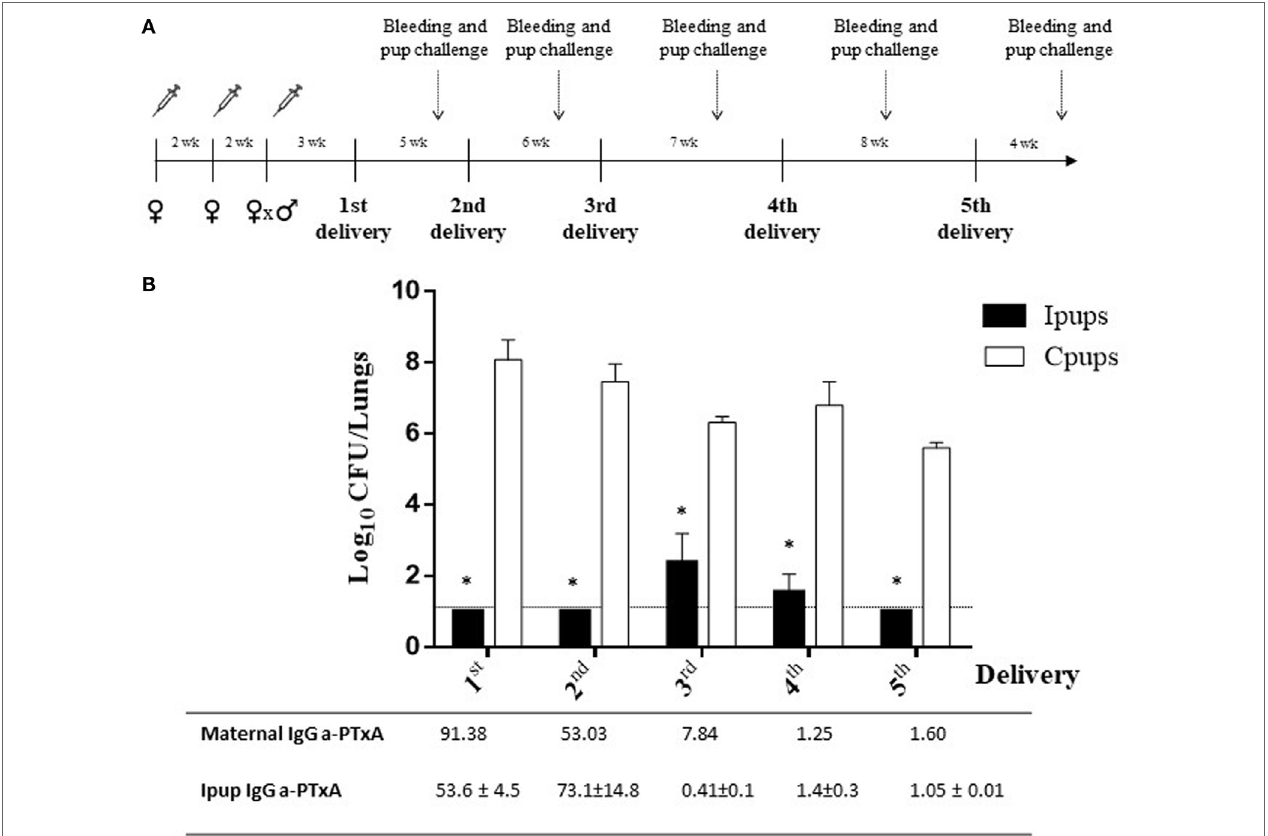
FigUre 2 | Duration of protective immunity conferred by maternal immunization beyond the first pregnancy. (a) Schematic representation of the maternal vaccination and pup-challenge protocol. Female mice were vaccinated twice with commercial acellular pertussis (aP) at a 2-week interval; mated with male mice; and when the vaginal plug was detected, a third aP dose was administered. Non-immunized females were mated with male mice at the same time as the immunized females. The first birth was 3–4 weeks after the last immunization. Successive births occurred at intervals of 5–8 weeks. Mice born to aP-immunized or non-immunized females (the negative controls) were challenged with Bordetella pertussis at 4 weeks after birth. Mothers and pups were bled 1 day before pup challenge as indicated by the dotted vertical arrows. (B) Protection conferred to the offspring born in later pregnancies by maternal immunity acquired during the first pregnancy. Mice born to aP-immunized (Ipups n = 5) or non-immunized (Cpups n = 5) females were challenged with B. pertussis Tohama I 4 weeks after birth. The protection conferred to the offspring through maternal immunization during the first pregnancy was estimated by determining the number of bacteria recovered from mouse lungs. The bacterial counts expressed as the log 10 of CFU per lungs, is plotted on the ordinate as a function of the number of births after the initial delivery indicated on the abscissa . * p < 0.001 Ipups versus Cpups. The anti-pertussis toxin (a-PTxA) IgG titers in the mothers and the offspring determined at the time of challenge are listed below the abscissa . The titers are expressed as the geometric mean of the data from each group ( n = 5). p < 0.001 a-PTxA IgG titers in Ipups from the first and second deliveries versus those detected in Ipups from the third through the fifth deliveries. The results from one representative experiment are